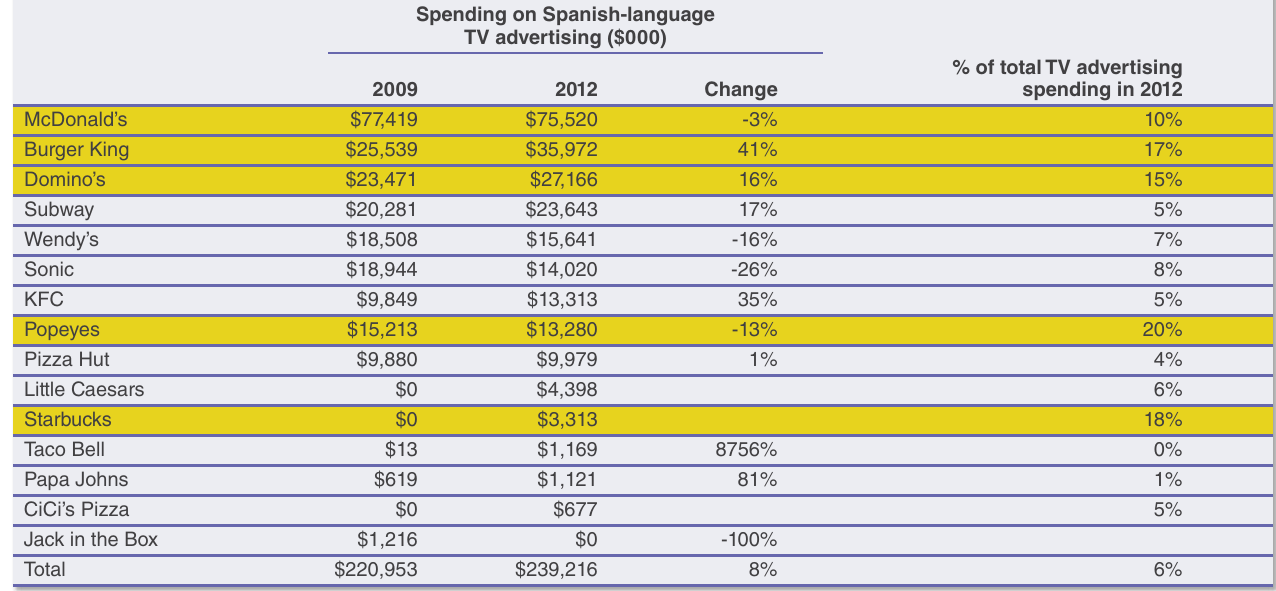
Table 38. Spending on Spanish-language TV